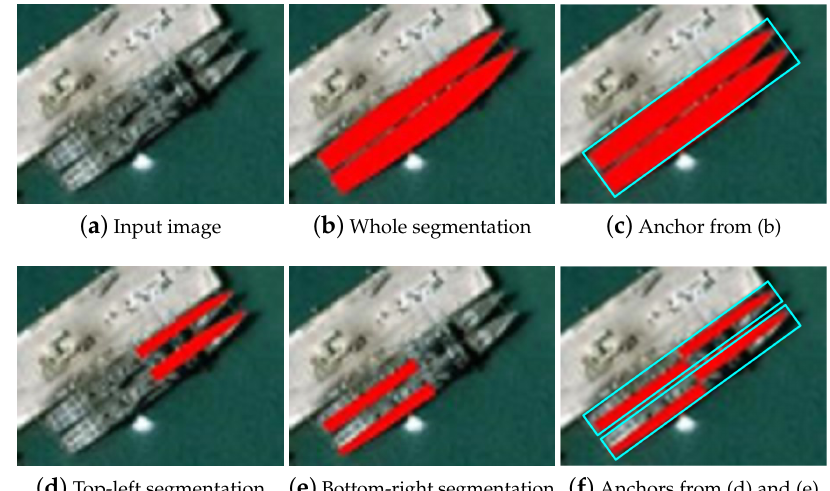
Figure 2. The whole ship segmentation result ( b ) would produce inaccurate anchor box (see ( c )). Using top-left and bottom-right segmentation parts (see ( d , e )) would generate more accurate anchors (see ( f